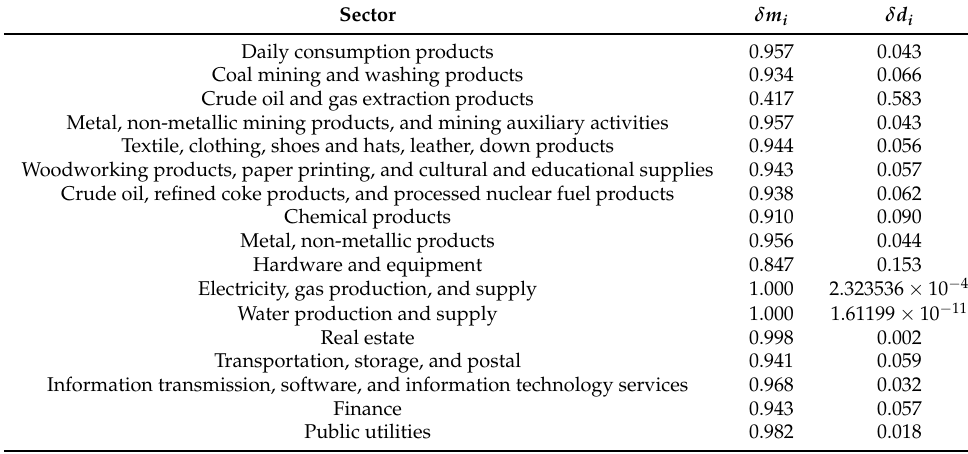
Table A5. The results of calibration of δ m i and δ d i